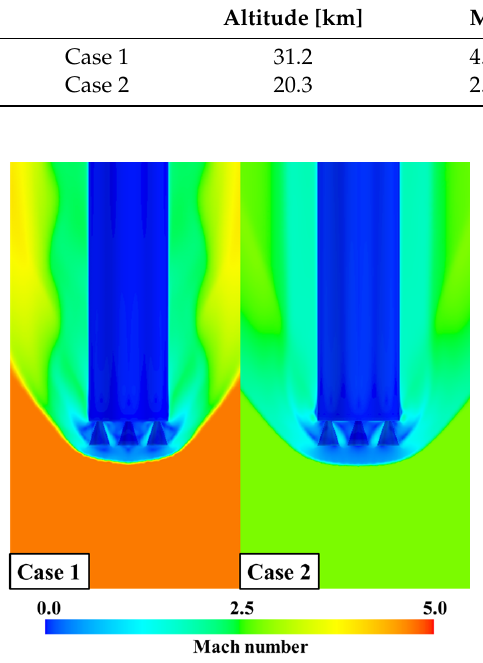
Figure 14. Mach number contour of validation cases. Figure 15. The thrust variation in the landing-burn phase took the form of a linear